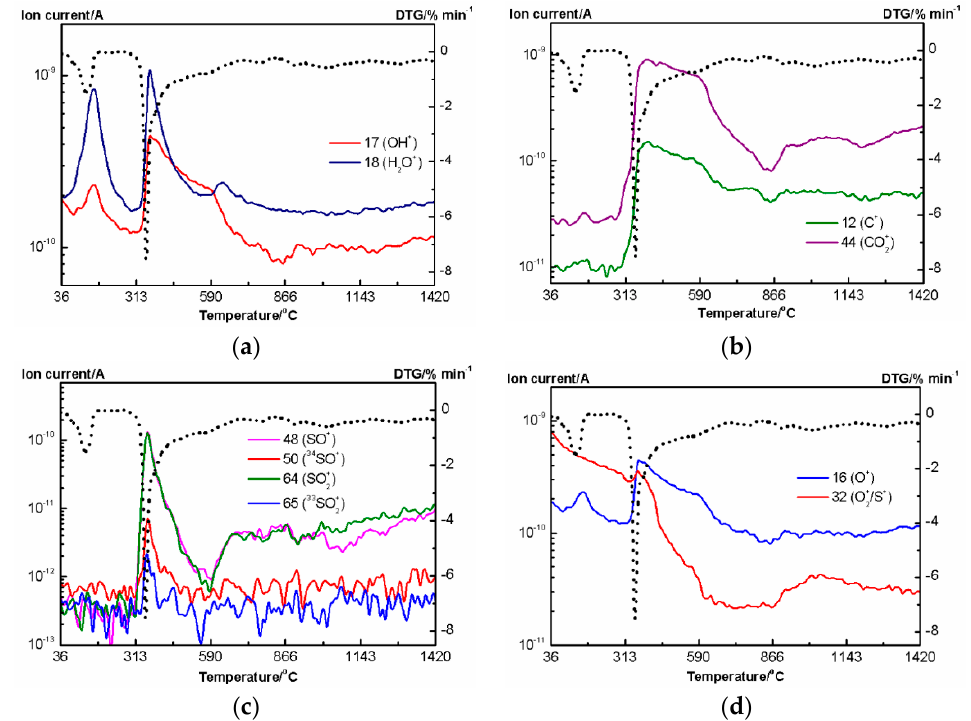
Figure 5. The ionic masses of gaseous products released during the thermal decomposition of 1 in helium and the corresponding ionic current tracks (the solid line) and a DTG run (the dotted line) related to the evolution of water ( a ), carbon oxides ( b ), sulfur dioxide ( c ) or selected species ( d )